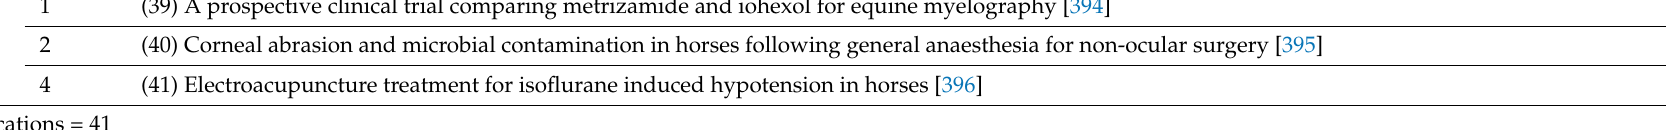
LoE: level of evidence. GA: general